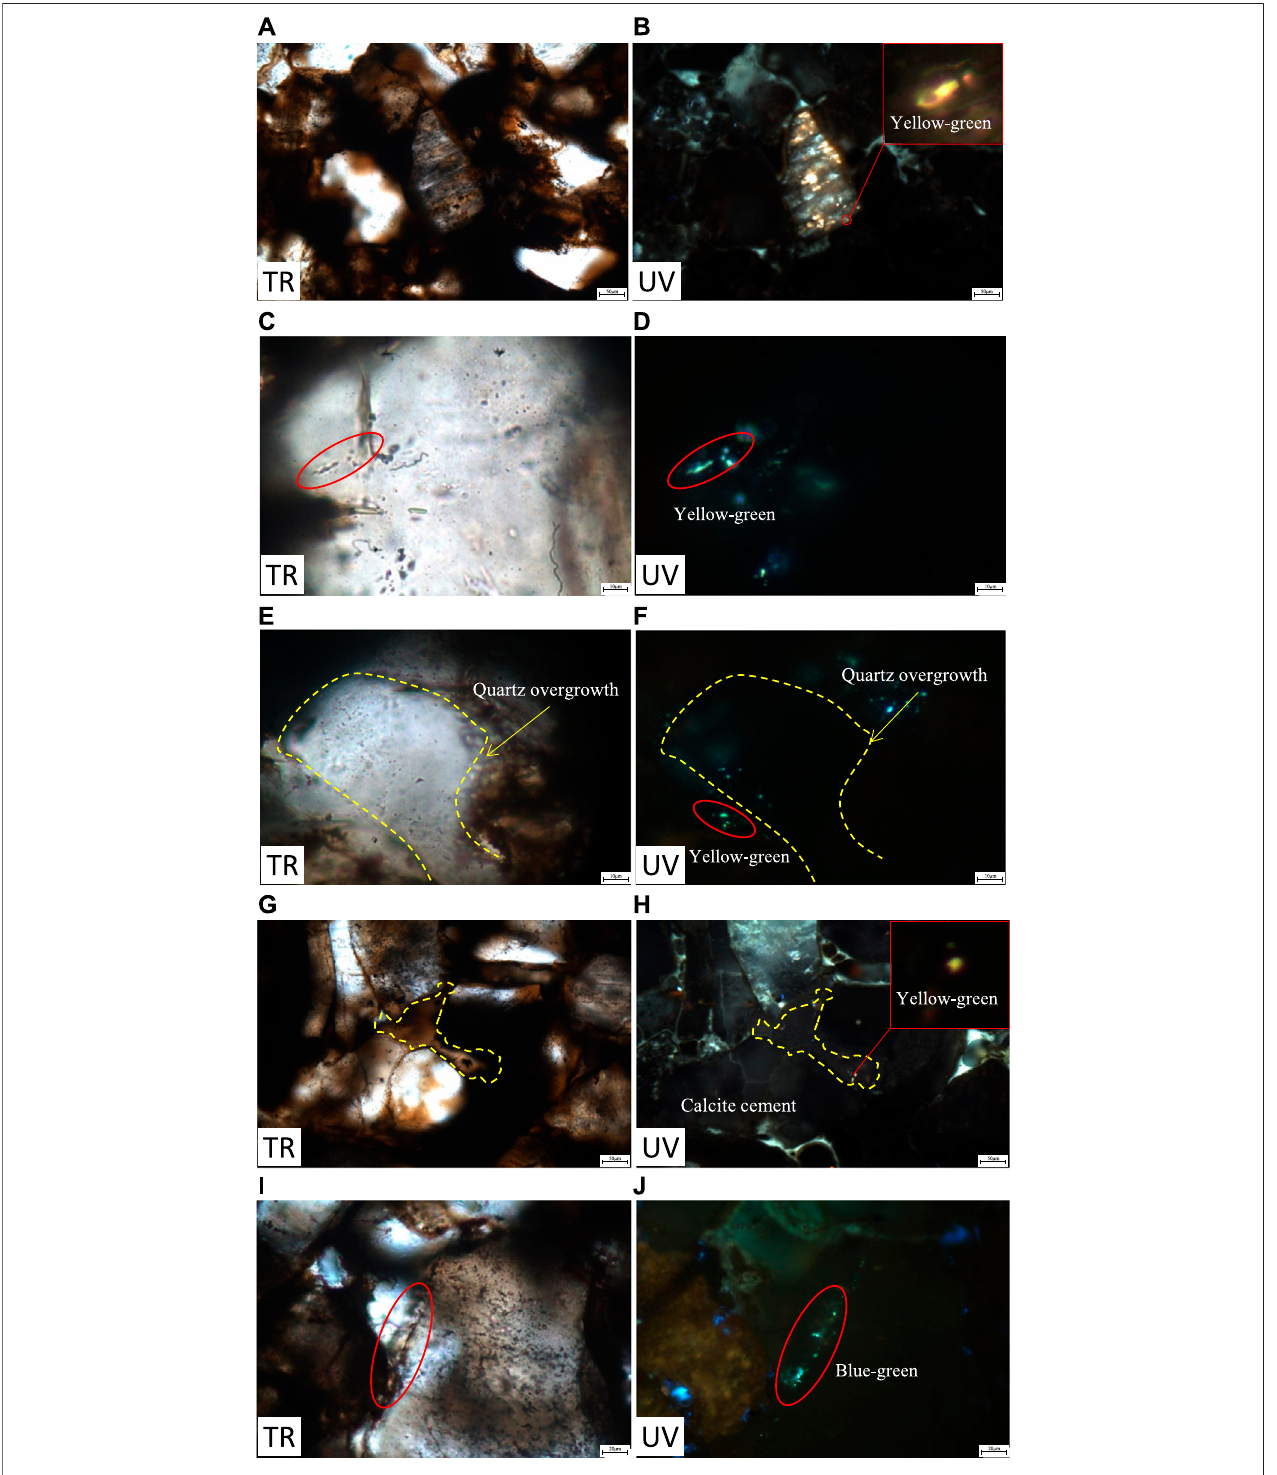
FIGURE 2 | Micrographs of representative oil inclusions under transmitted light (TR) and ultraviolet light (UV) in the FGSR samples. (A,B) Sample 2413.48 m, well Y75: yellow – green fl uorescing oil inclusions in the dissolved pores of feldspar grains. (C,D) Sample 2166 m, well Z218: yellow – green fl uorescing oil inclusions along multiple healed fractures of a quartz grain. (E,F) Sample 2517.1 m, well Z74: yellow – green fl uorescing oil inclusions along healed fractures of quartz overgrowth. (G,H) Sample 2360.5 m, well Y75: yellow – green fl uorescing oil inclusions in the calcite cement. (I,J) Sample 2532.6 m, well Y208: blue – green fl uorescing oil inclusions along the fracture through the quartz grain.